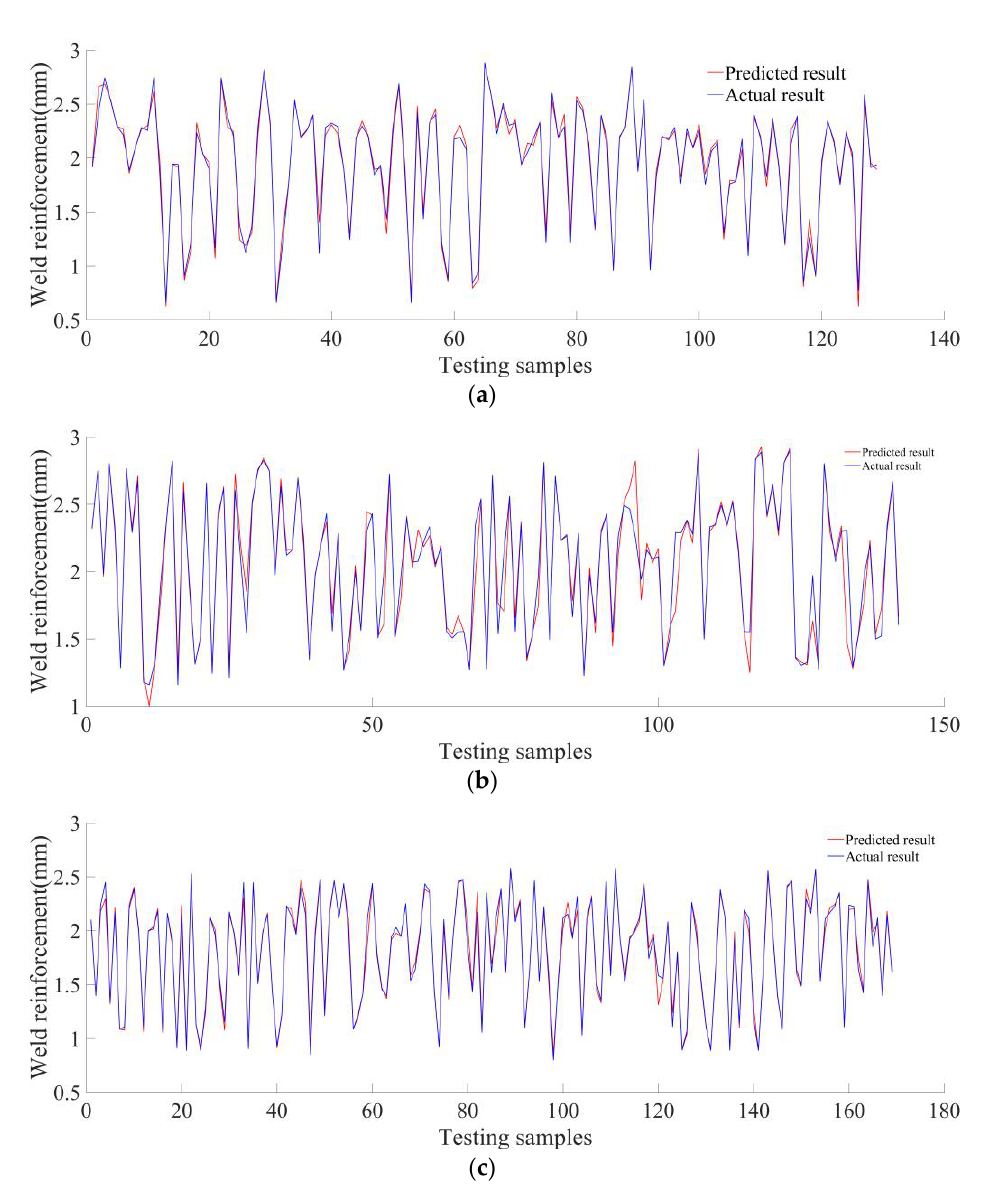
Figure 9. Predicted results of weld reinforcement. ( a ) Third cladding layer; ( b ) Fourth cladding layer; ( c ) Fifth cladding layer. ( c ) Fifth cladding